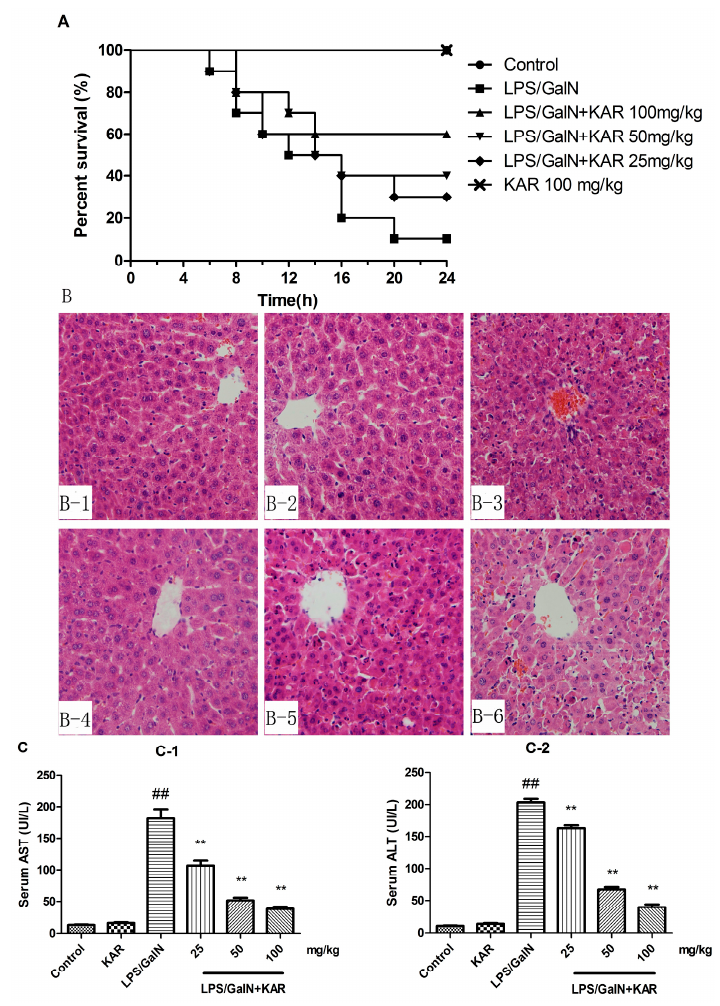
Figure 2. Effect of KAR on D-GalN/LPS-induced mouse acute liver injury. ( A ) Effect of KAR on the survival of mice in each group; ( B ) histopathological observation of liver tissue sections in control group ( B1 ); KAR control group ( B2 ); FHF model group; ( B3 ) and KAR treatment group ( B4 – 6 ) (magnification 200×); the activity of AST ( C1 ) and ALT ( C2 ) in serum was measured by assay. The data represented show the mean ± SD ( n = 15). ** p < 0.01 compared to the FHF model group, and ## p < 0.01 compared to the control